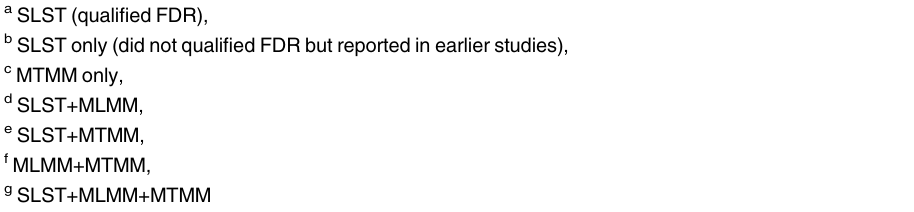
Table 7. SSRs involved in important MTAs identified through different approaches or their combinations. S. Trait No.